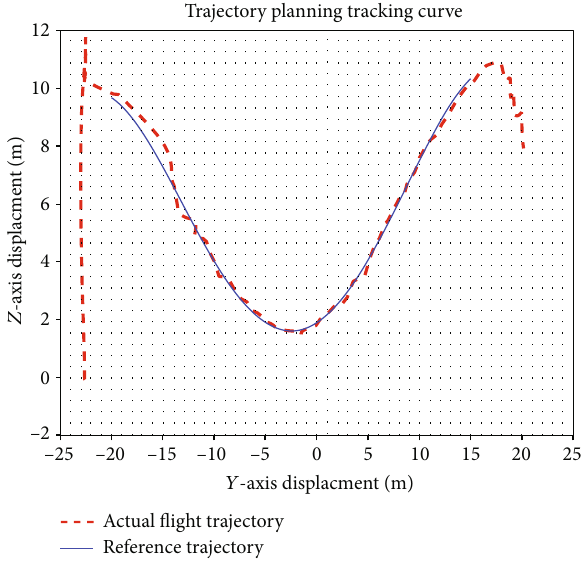
Figure 19: Trajectory planning tracking